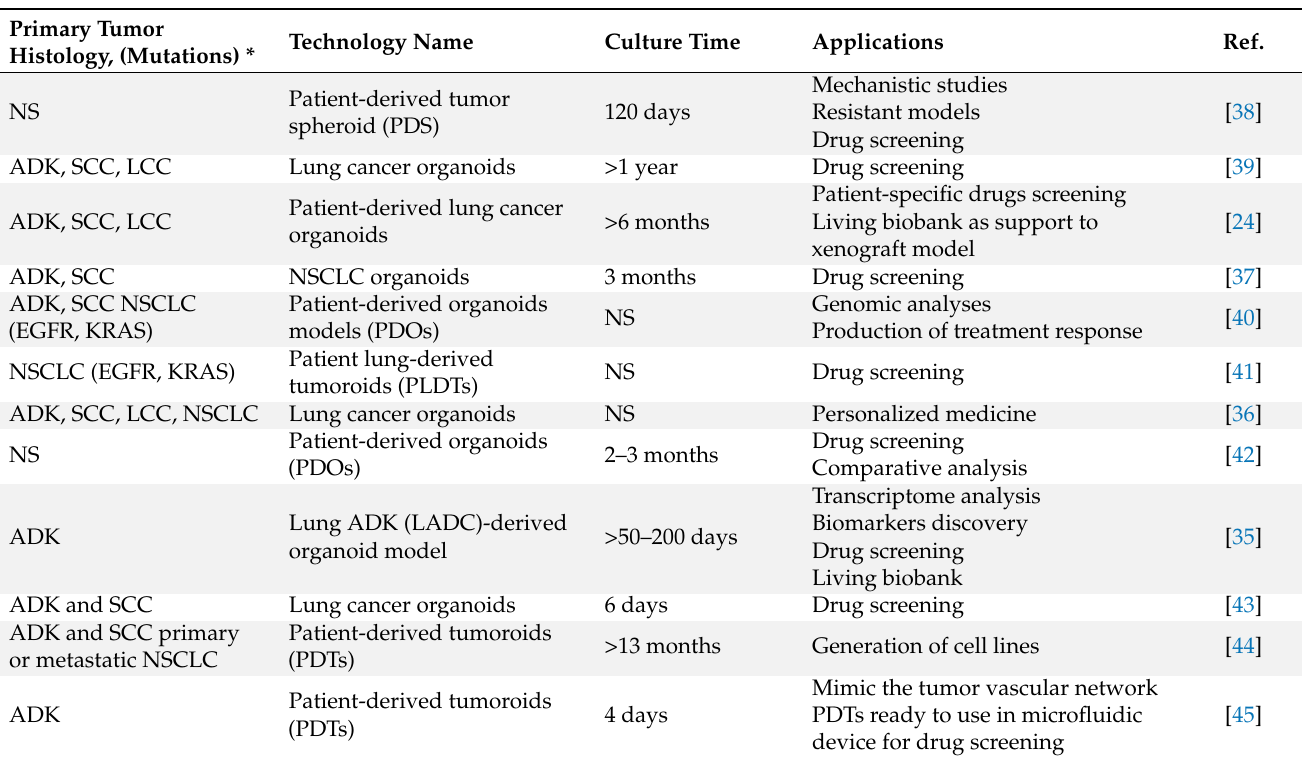
Table 2. Current lung organoid/tumoroid